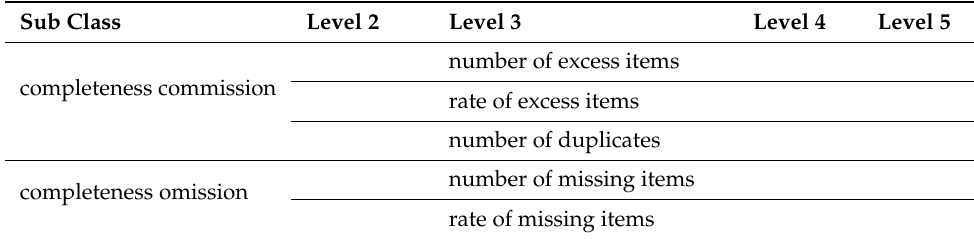
Table A7. Spatial data quality matrix for class completeness.